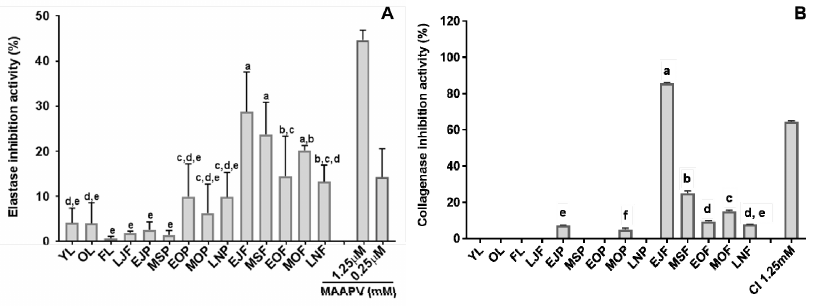
Figure 2. Anti-aging activity of tissues and fruit-maturity stages of C. unshiu . ( A ) Elastase inhibitory activity, ( B ) Collagenase inhibitory activity. Data are expressed as mean ± SD (n = 3), and different small letters indicate a significant difference by Duncan’s test; p < 0.05.